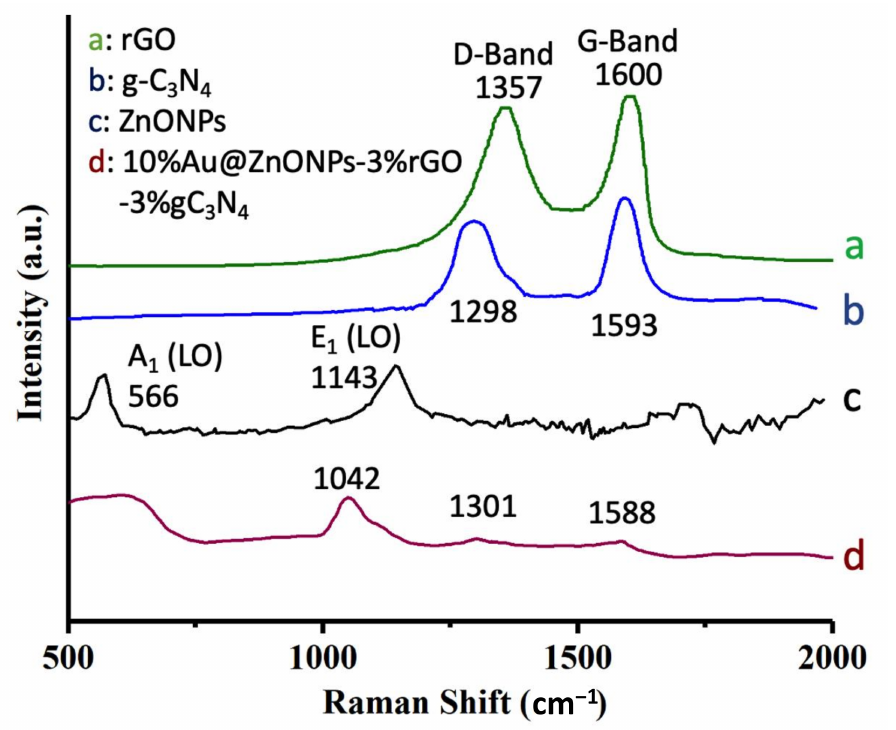
Figure 4. ( a ) Raman spectra of rGO; ( b ) gC 3 N 4 ; ( c ) ZnONPs; and ( d ) 10%Au@ZnONPs-3%rGO- 3%gC 3 N 4